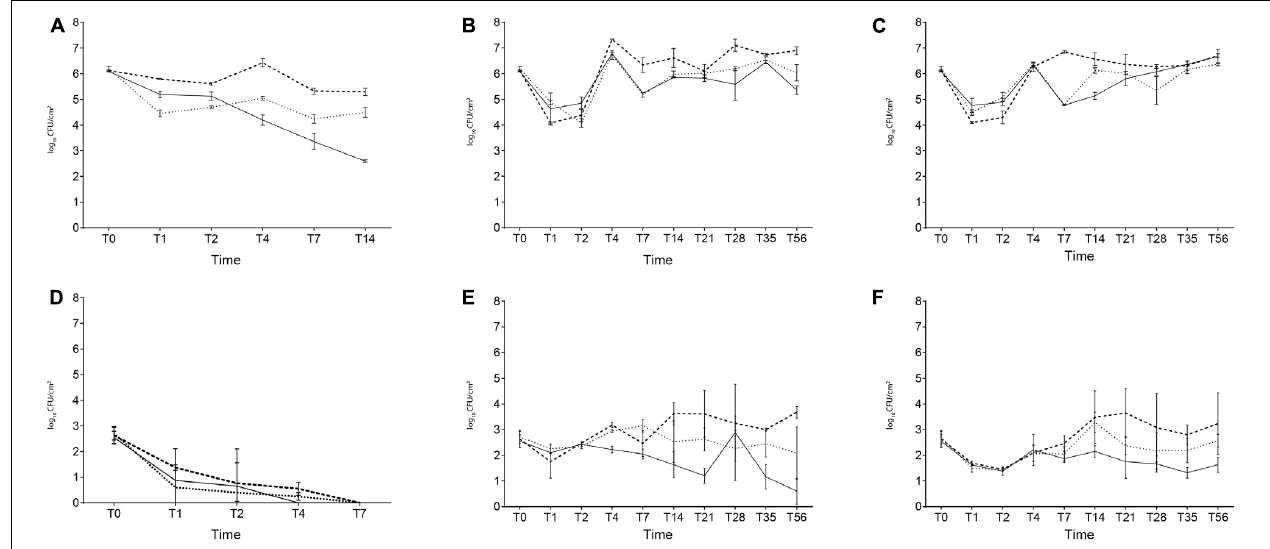
FIGURE 1 | The microbial populations of TVC (A–C) and L. monocytogenes (D–F) recorded during storage at 37 ◦ C (A,D) , 12 ◦ C (B,E) , and 4 ◦ C (C,F) . Dotted line, polyethylene-coated parchment; solid line, polyethylene-coated nylon; dashed line, greaseproof paper.